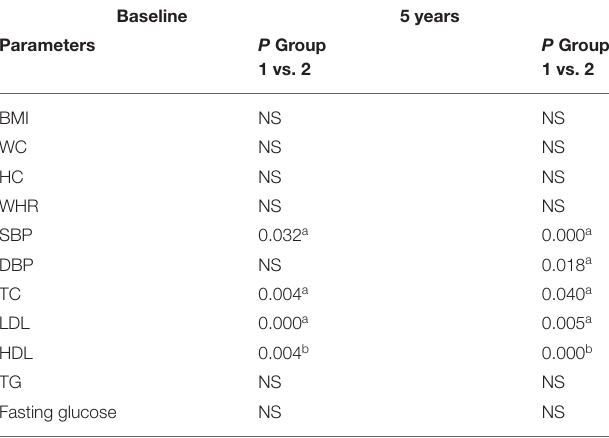
TABLE 5 | Comparison between patients (group 1) and controls (group 2) at baseline and after 5-year follow-up.